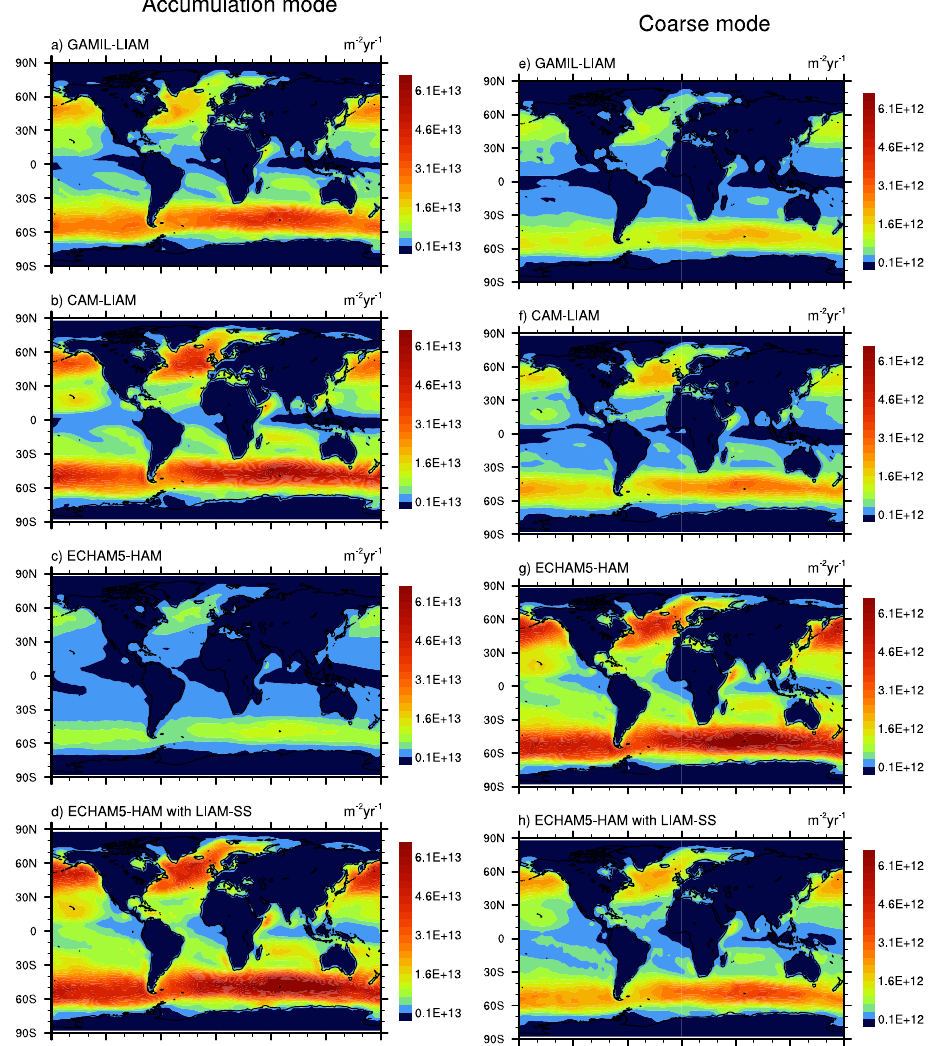
Fig. 5. Annual mean number flux of the soluble accumulation mode (left column) and soluble coarse mode (right column) caused by sea salt emission in different models and experiments. The unit is m − 2 yr − 1 . “LIAM-SS” refers to the sea salt emission scheme of the LIAM